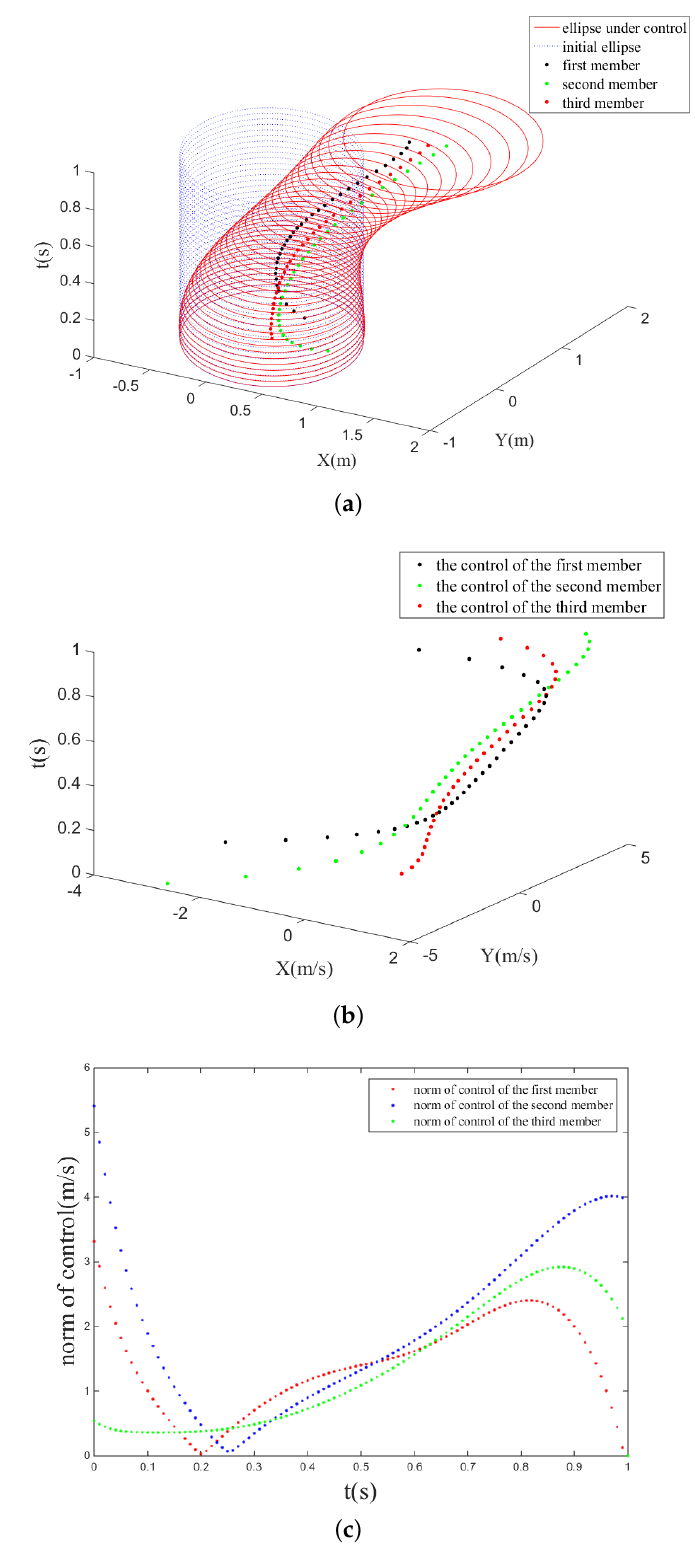
Figure 1. Team motion with initial states x 1 ( 0 ) = [ 0,0.5 ] , x 2 ( 0 ) = [ 0.5,0 ] , x 3 ( 0 ) = [ 0,0 ] and parameters ω = 0.1, β 1 = 5.87, β 2 = 5.88, β 3 = 5.85, κ 12 = 1.13, κ 13 = 1.15, κ 23 = 1.10. ( a ) The state-time relationship diagram of the cluster. ( b ) The control-time relationship diagram of the cluster. ( c ) The norm of the control-time relationship diagram of the